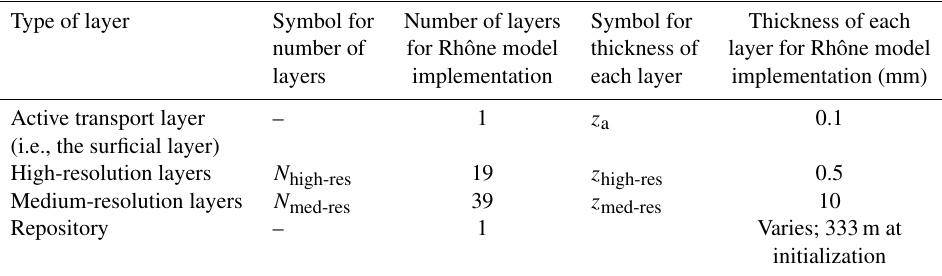
Table A1. Parameters for new seabed layering scheme, as implemented for the Rhône study site. Dashed lines indicate that no symbol was assigned to that